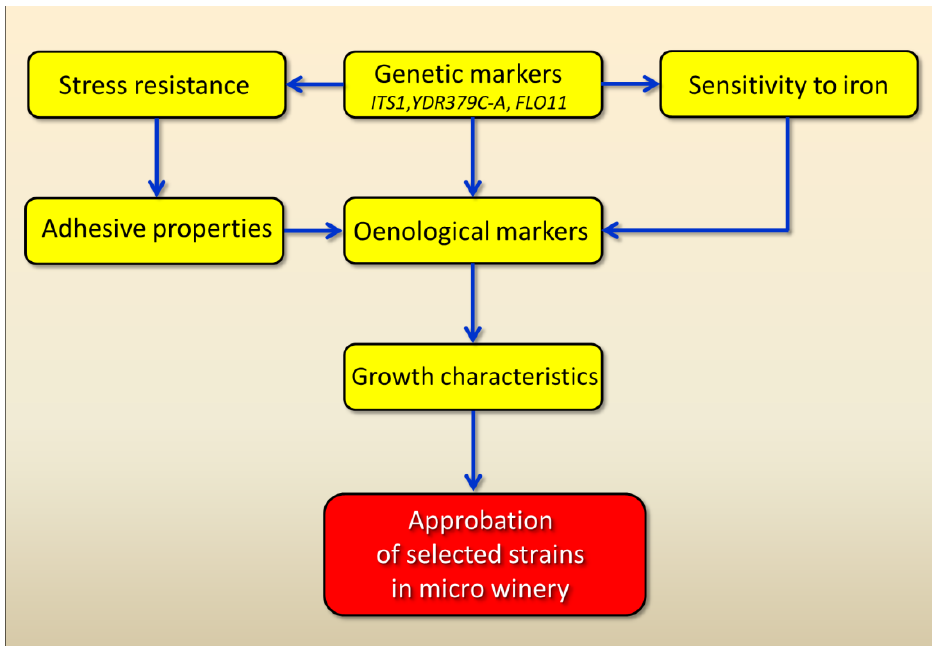
Figure 4. Stages of screening yeast S. cerevisiae , promising for the production of sherry.